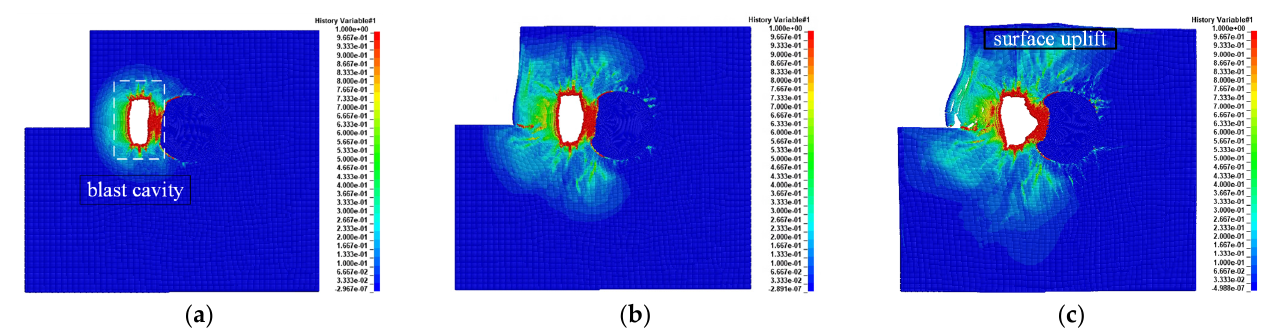
Figure 12. Rock-breaking effect under water medium filling; ( a ) t = 2 × 10³ μ s; ( b ) t = 4 × 10³ μ s; ( c ) t = 8 × 10³ μ s.